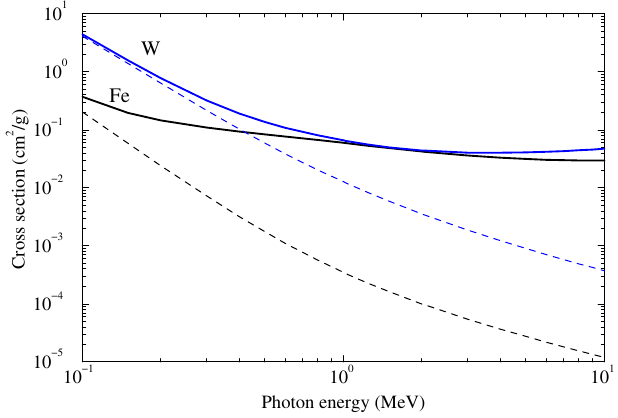
FIG. 9. (Color) Photon total (solid line) and photoabsorption (dashed line) cross sections for iron and tungsten